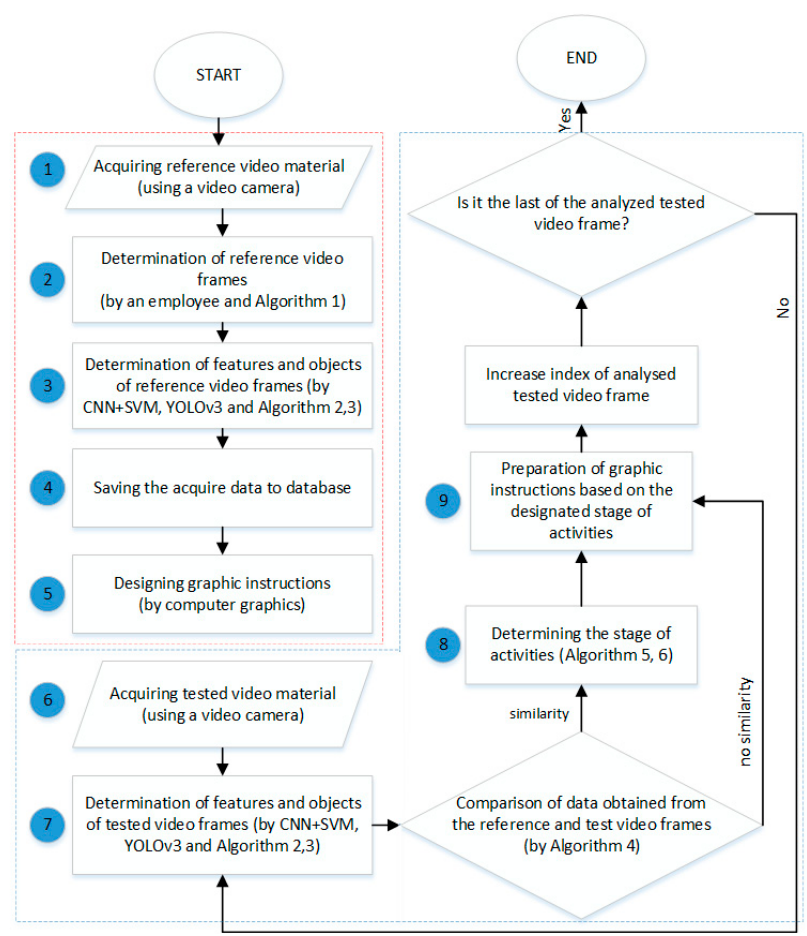
Figure 2. Flowchart of the approach to the automatic generation of work instructions.